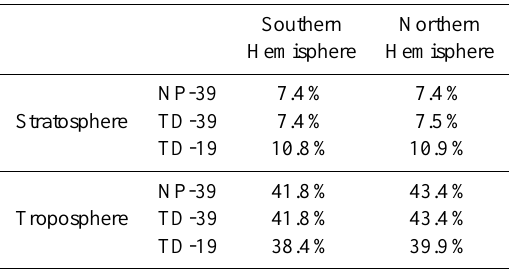
Table 4. Percentage (%) of the total atmospheric SF 6 burden com- puted in four boxes (Troposphere in the Southern Hemisphere, tro- posphere in the Northern Hemisphere, stratosphere in the Southern Hemisphere and stratosphere in the Northern Hemisphere) for two LMDz configurations using 39 levels (NP-39 and TD-39) and one another using 19 levels